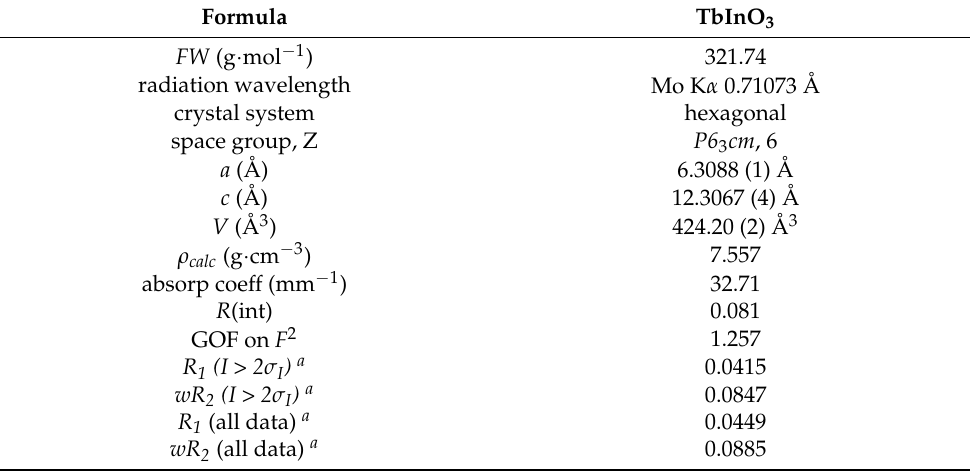
Table 1. Crystal data and structure refinement for TbInO 3.